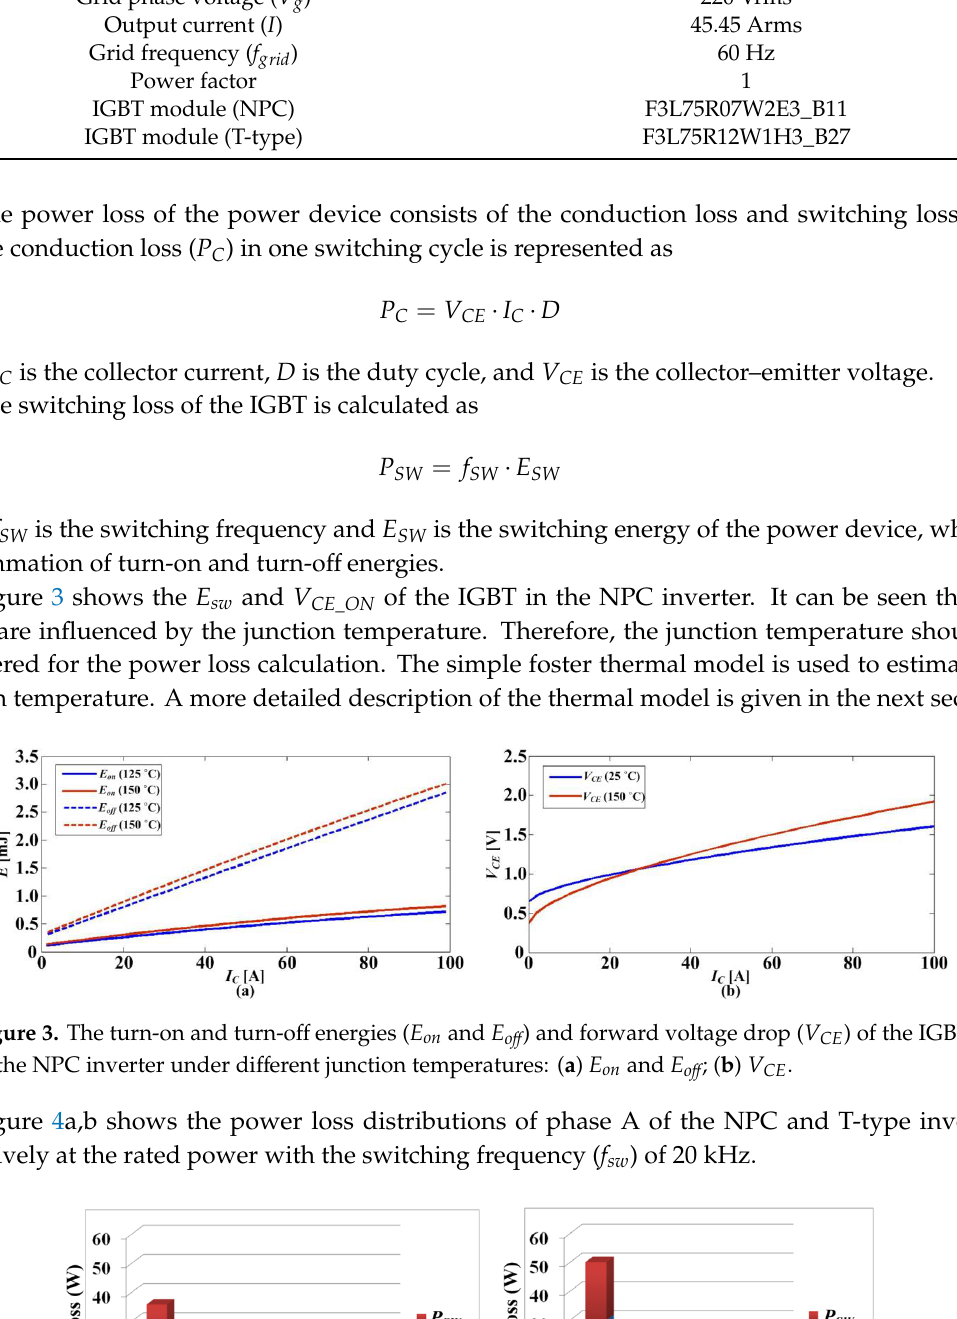
Table 1. Parameters for 30 kW photovoltaic (PV) inverter system. NPC: neutral-point clamped. Parameters